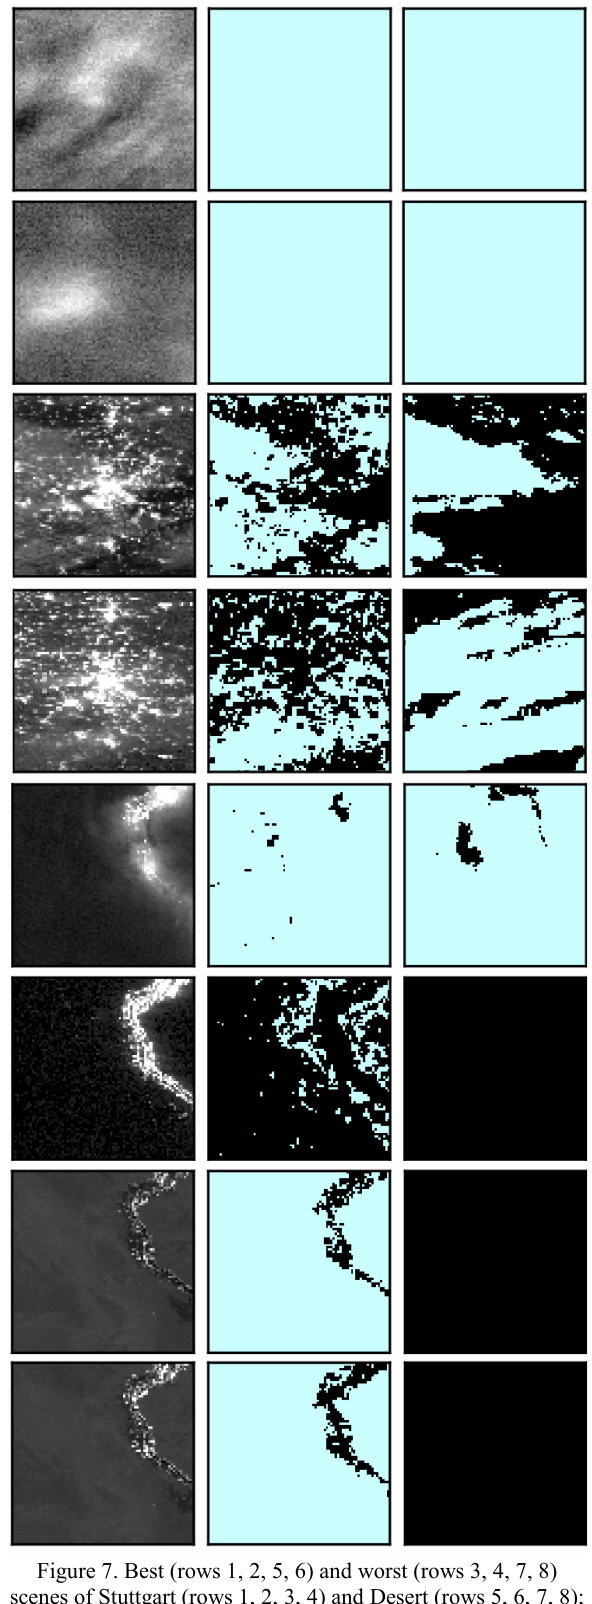
Figure 7. Best (rows 1, 2, 5, 6) and worst (rows 3, 4, 7, 8) scenes of Stuttgart (rows 1, 2, 3, 4) and Desert (rows 5, 6, 7, 8); left: DNB, right: ECM, middle: result of classification (blue: cloud, black: